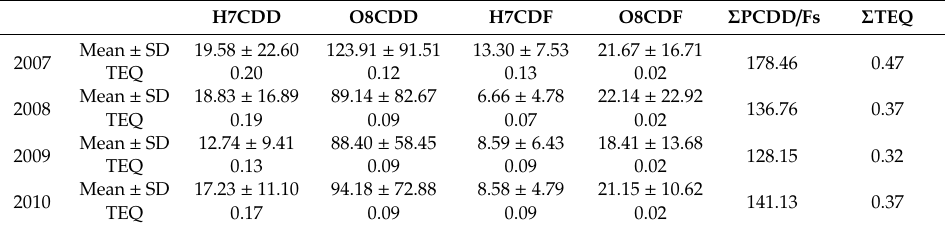
Table 3. Mean ( ± SD) annual concentrations (ng / kg) PCCDs and dibenzofurans (PCDFs) (n = 4), and TEQs (toxic equivalents) calculated for total PCCD / Fs, based on Toxic Equivalency Factors (TEFs) according to the WHO (World Health